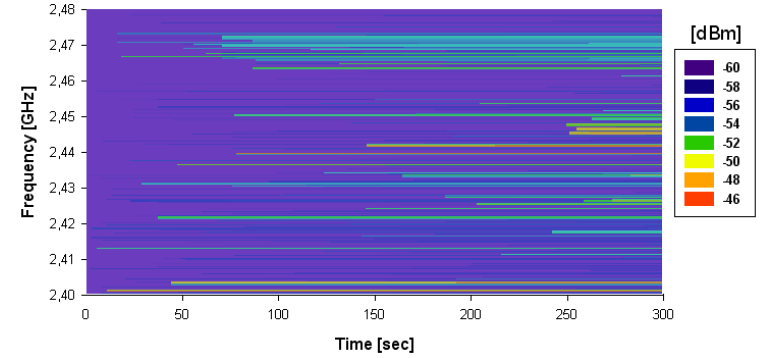
Figure 10. Measured spectrogram in 2.4 GHz ISM band, in the operating region of the Bluetooth wireless link of the HOLTIN-Smartphone connection.